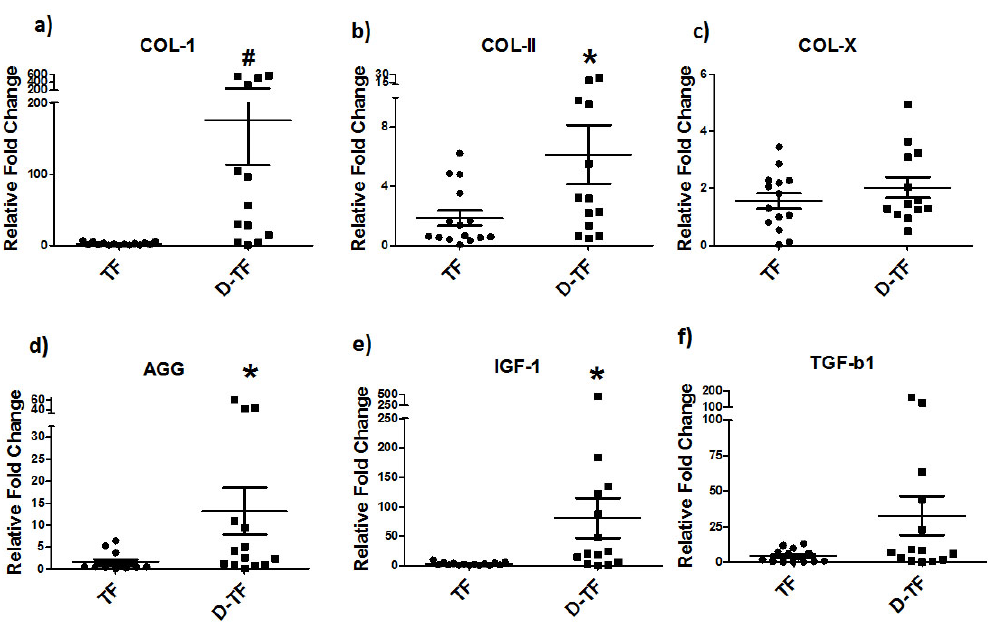
Figure 3: Extracellular matrix and growth factors genes dysregulated in diabetic trigger finger samples. ( a ) Collagen1, ( b ) Collagen 2, ( c ) Collagen X, ( d ) Aggrecan, ( e ) IGF1 and ( f ) TGFb1 gene expression level dysregulated in diabetic trigger finger (D-TF) samples compare to